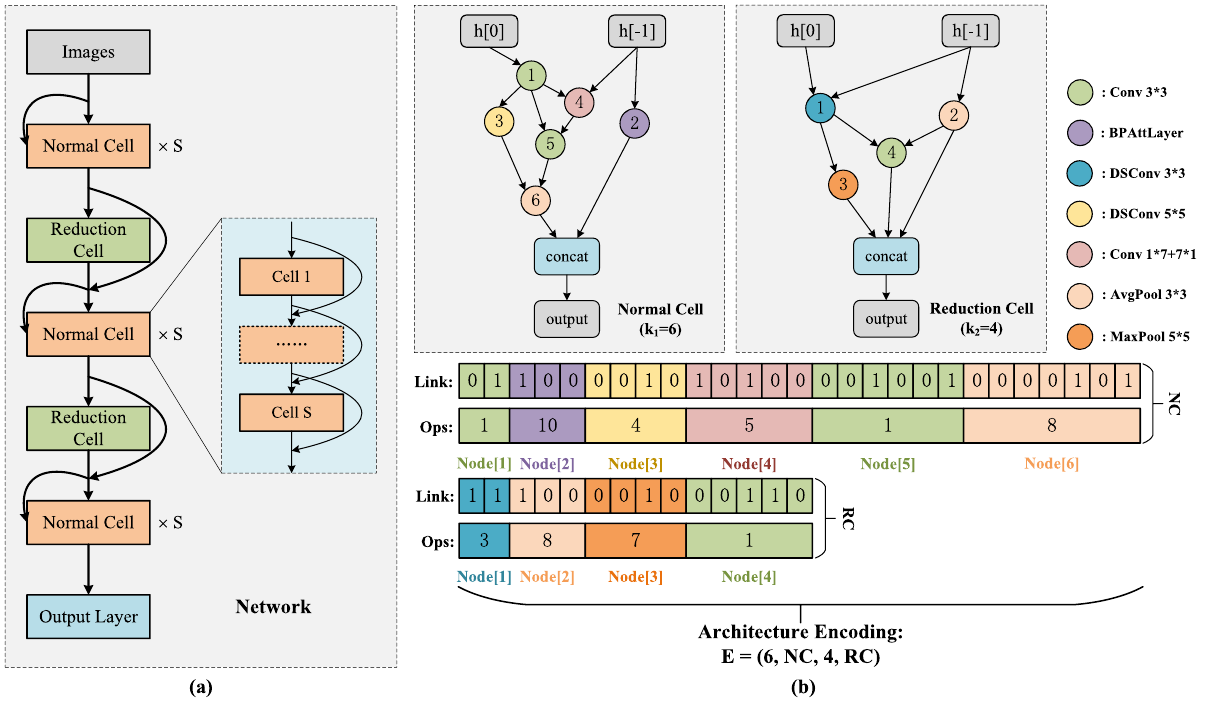
b The two example basic cells represented by directed acyclic graphs (DAG) contain six and four nodes, respectively (i.e., normal cell and reduction cell), and the corresponding architecture